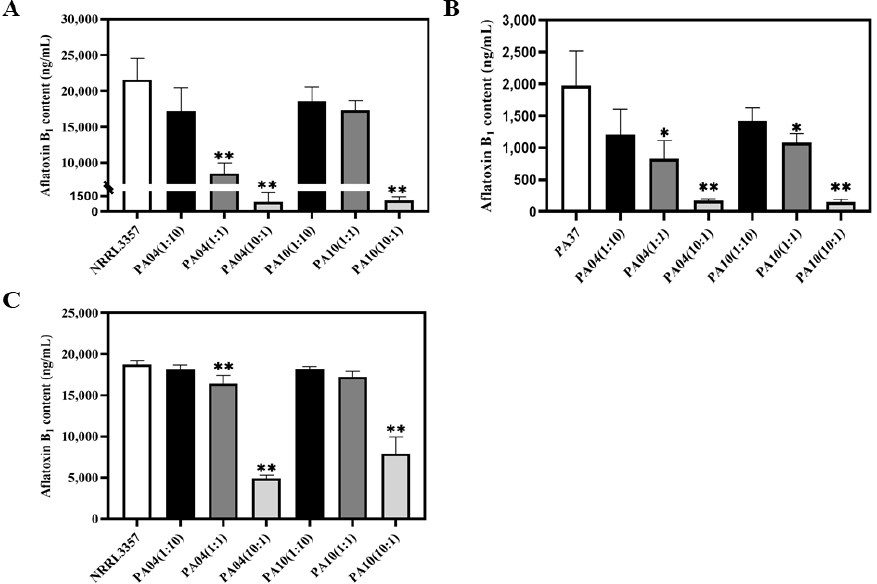
Figure 4. AFB 1 concentrations as determined by ELISA resulting from co-culture of ei ther atoxigenic strains with NRRL3357/PA37. Peanut inoculated with different proportions of A. flavus strains and incubated at 30 °C for seven days ( A , B ). PDA media inoculated with different proportions of A. flavus strains and incubated at 30 °C for 10 days ( C ). (* p < 0.05, ** p < 0.001).